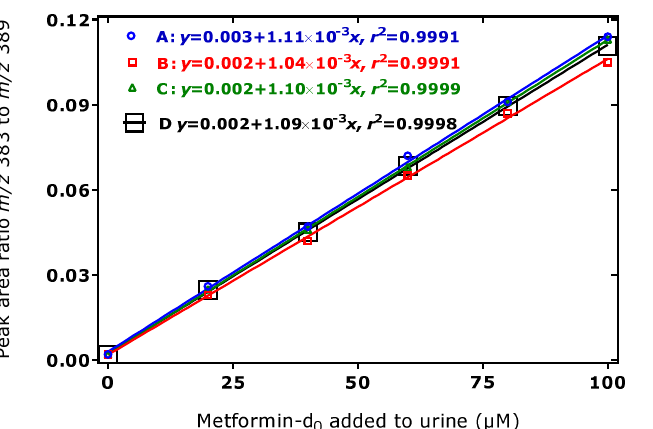
Figure 2. Relationships between the peak area ratio of m/z 383 to m/z 389 ( y ) and the metformin-d 0 concentration added to a human urine sample. Three separate experiments were performed (A, B, C). In (D), the data of the individual experiments are combined. The nominal metformin-d 6 con- centration was 1000 µM . For more details, see the text.